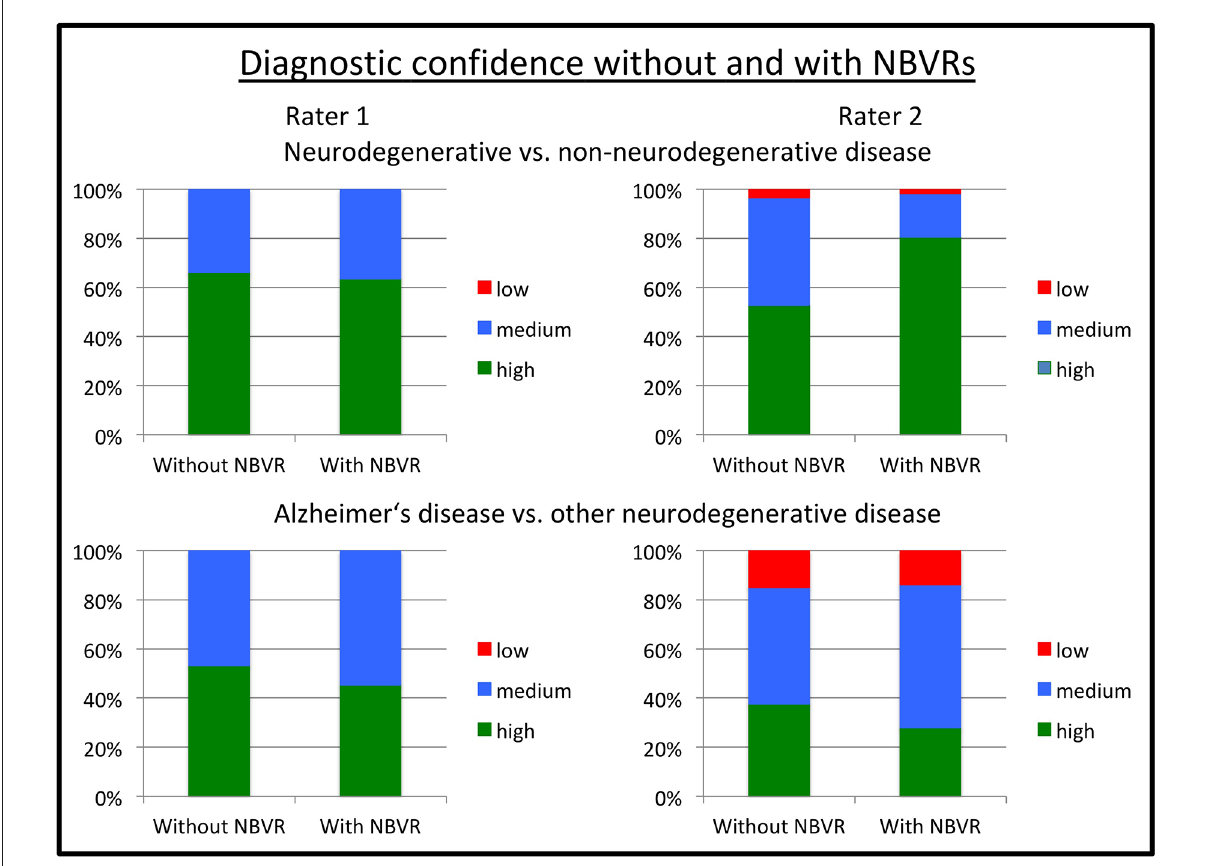
FIGURE3 Diagnostic confidence without and with NBVR information. Ratings on a three-point Likert scale ranging from 1 (“high confidence”) to 3 (“low confidence”) are shown for rater 1 (left column) and rater 2 (right column). Diagnostic questions were the identification of any neurodegenerative pattern (upper row) and the identification of a pattern suggestive of Alzheimer’s disease (AD; lower row). We observed increased diagnostic confidence in distinguishing patients with neurodegenerative disorders from patients without evidence of neurodegeneration on FDG-PET for rater 2 ( p < 0.001). Abbreviations: NBVR, Normative brain volume report; FDG-PET, Fluorodeoxyglucose-Positron Emission